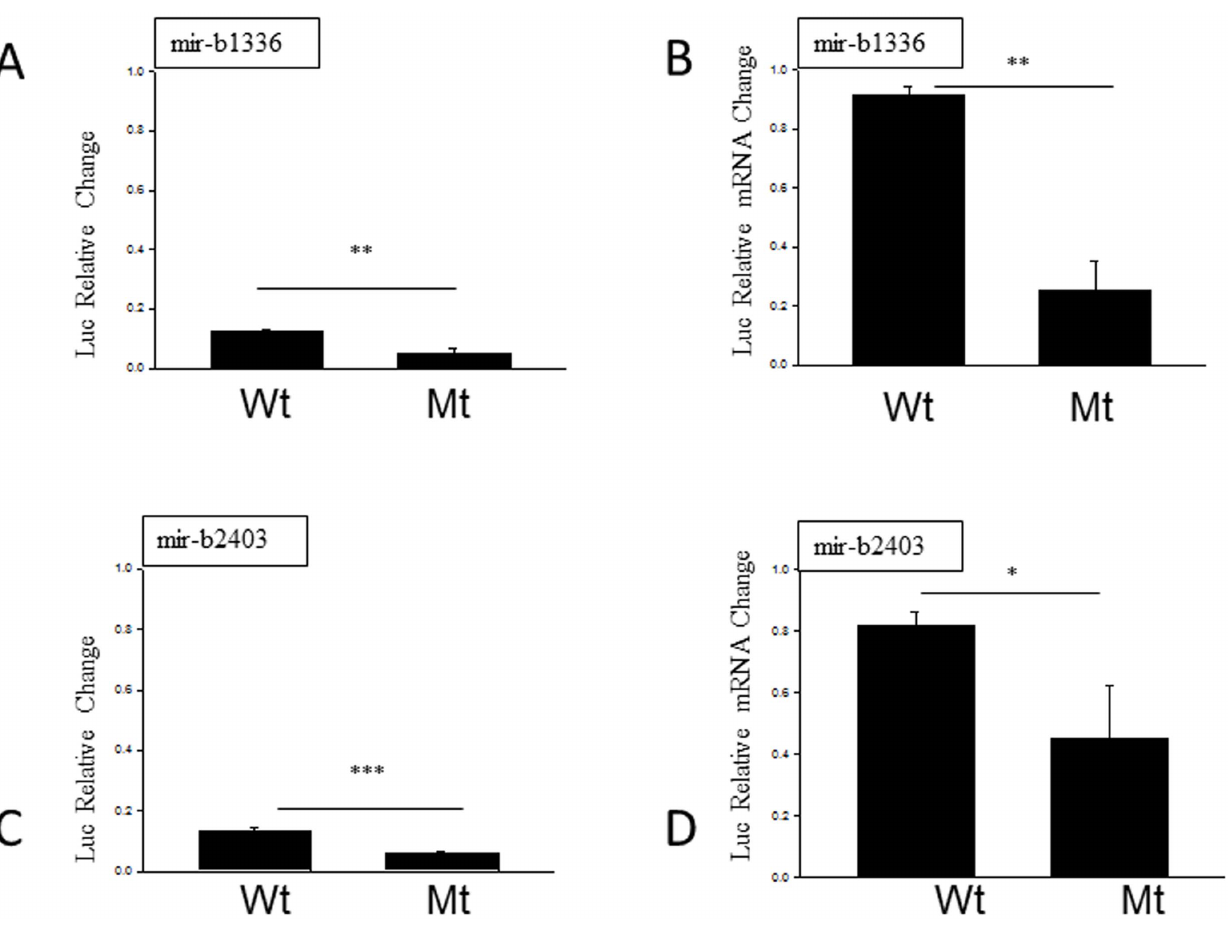
Figure 6. Mutations of the seed sequence of novel miRNAs (shown at Mt) compared to intact seed sequences (Wt) confirmed that both mir-b1336 and mir-b2403 interact directly with their respective seed sequences. A and C show the results of the luciferase reporter assay while B and D show the results from the RT-PCR analysis from mir-b1336 and mir-b2403, respectively. Data are expressed in terms of relative change and show up-regulation as positive values and down-regulation as negative values. Experiments were performed in triplicate. Results are shown as mean 6 SEM (t-test: *** =p , 0.001; **=p , 0.005; *=p , 0.05).